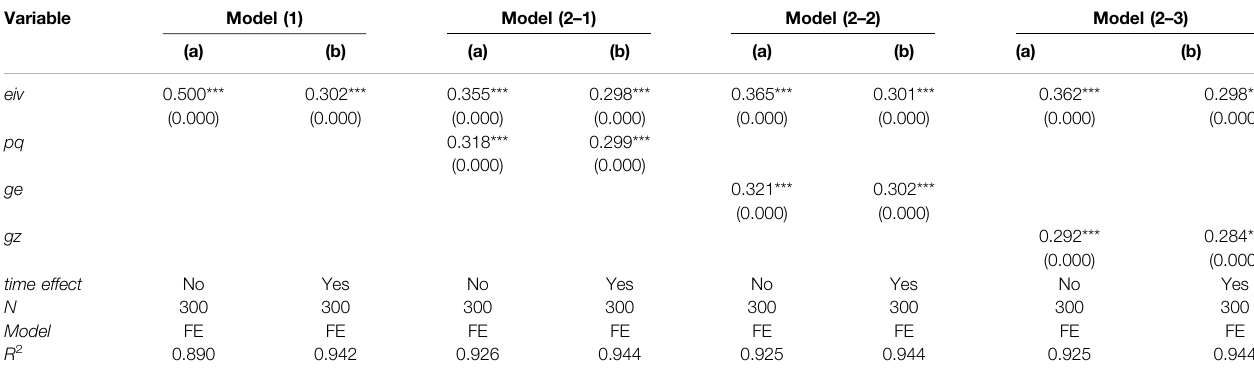
TABLE 4 | Baseline results.